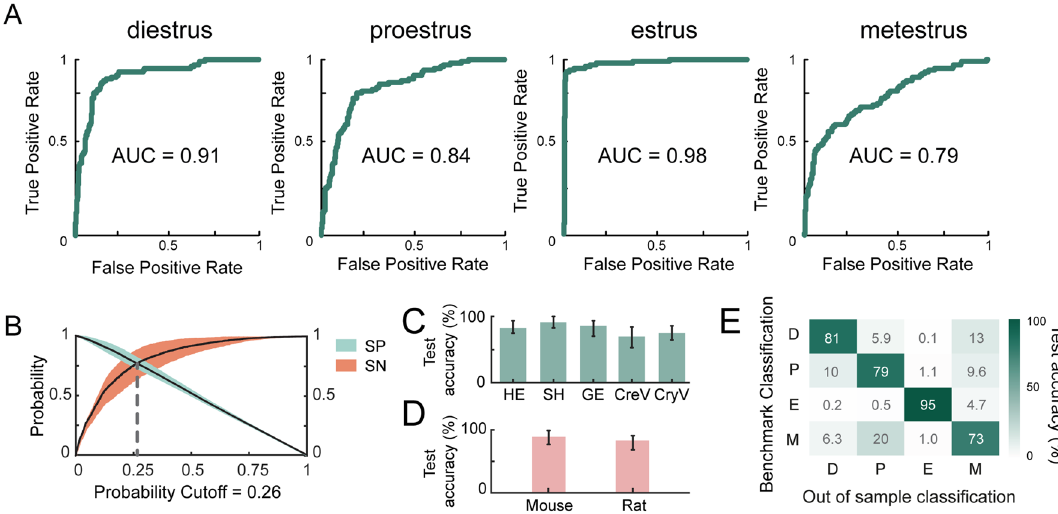
Figure 3. EstrousNet performs similarly across groups. ( A ) auROC curves for each estrous stage. True positives for each stage are determined by benchmark classifications. ( B ) Specificity (SP) vs. sensitivity (SN) curves for EstrousNet, with the probability cutoff at 0.26 defined as the intersection between curves (dotted grey line). Standard error shown in orange and blue for sensitivity and specificity, respectively. ( C ) Out of sample testing across 4 different stains: hematoxylin and eosin (HE), Shorr stain (SH), Giemsa stain (GE), cresyl violet (CreV), and crystal violet (CryV). Test accuracy represented as a distribution across 1000 testing iterations, with mean % SE shown. Accuracy differences between stains are not significant [ F (4,198) = 3.14, p = 0.10, one-way ANOVA]. ( D ) Out of sample testing between mouse and rat species. Test accuracy represented as a distribution across 1000 testing iterations, with mean % SE shown. Accuracy differences between species are not significant [ F (1,198) = 7.87, p = 0.73, one-way ANOVA]. ( E ) Out of sample (OOS) classification for each stage of the estrous cycle between n = 36 animals, represented as a heatmap. Benchmark classification was used as a proxy for ground truth. K-fold cross-validation was used to estimate accuracy across stages, with k = 6 groups of n = 6 subjects each. Testing accuracy was averaged between each fold to generate the most unbiased estimate across all groups. Accuracy differences between subjects are not significant ( F (5,198) = 6.98, p = 0.60, one-way